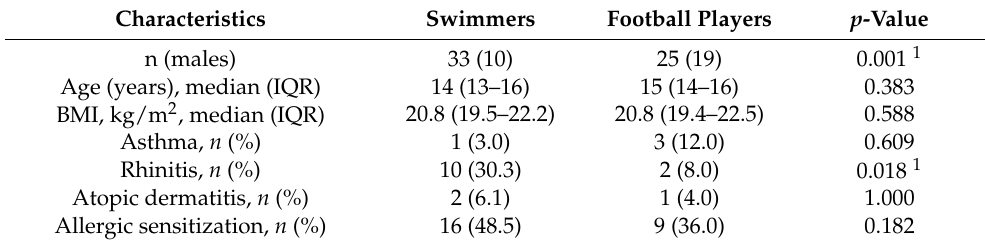
Table 1. Characteristics of